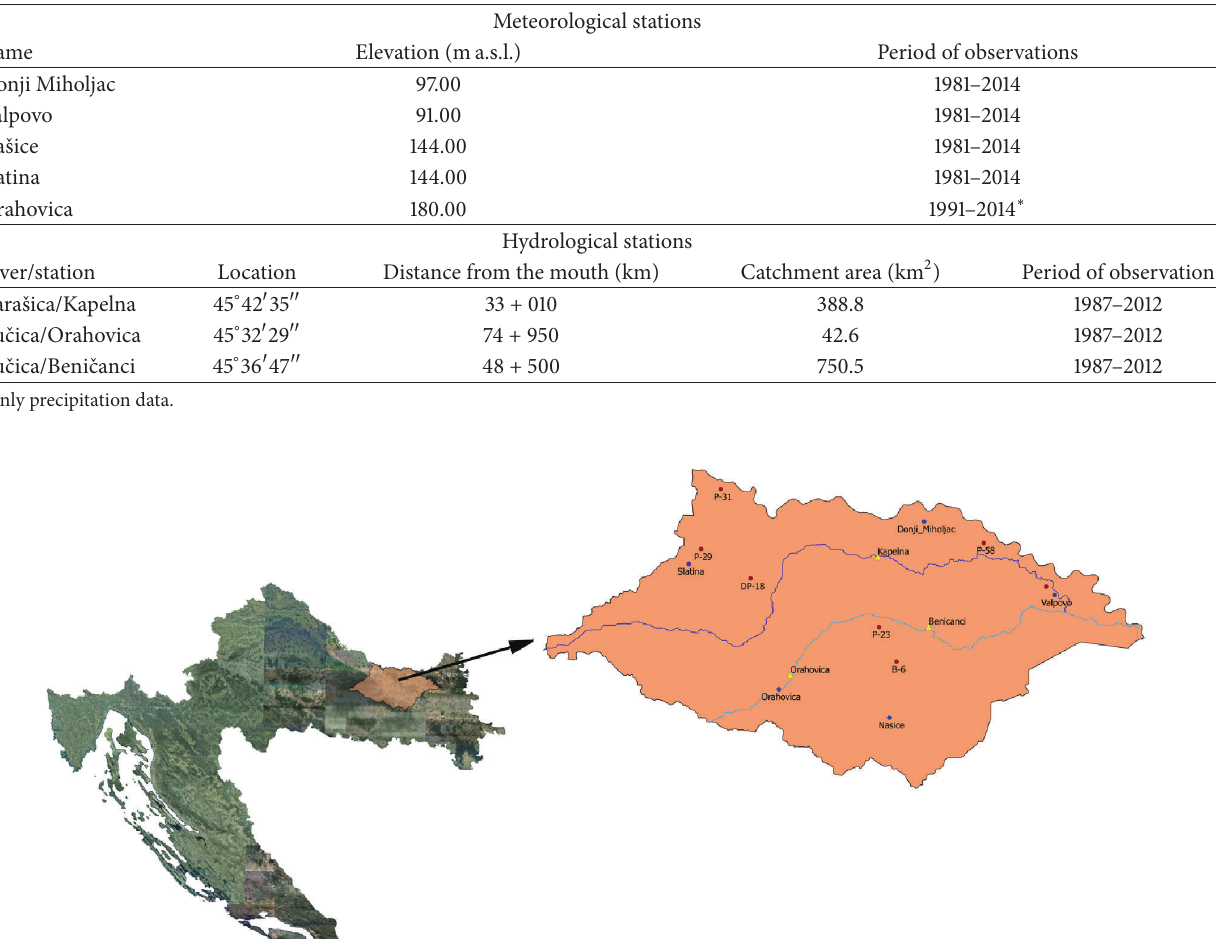
Table 1: Characteristics of meteorological and hydrological stations.